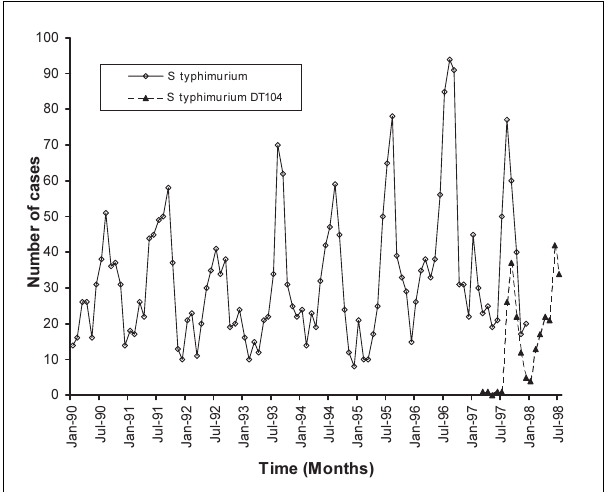
Figure 2) Temporal Distribution of Salmonella serotype typhimurium (S typhimurium) and S typhimurium definitive type 104 (DT104) cases